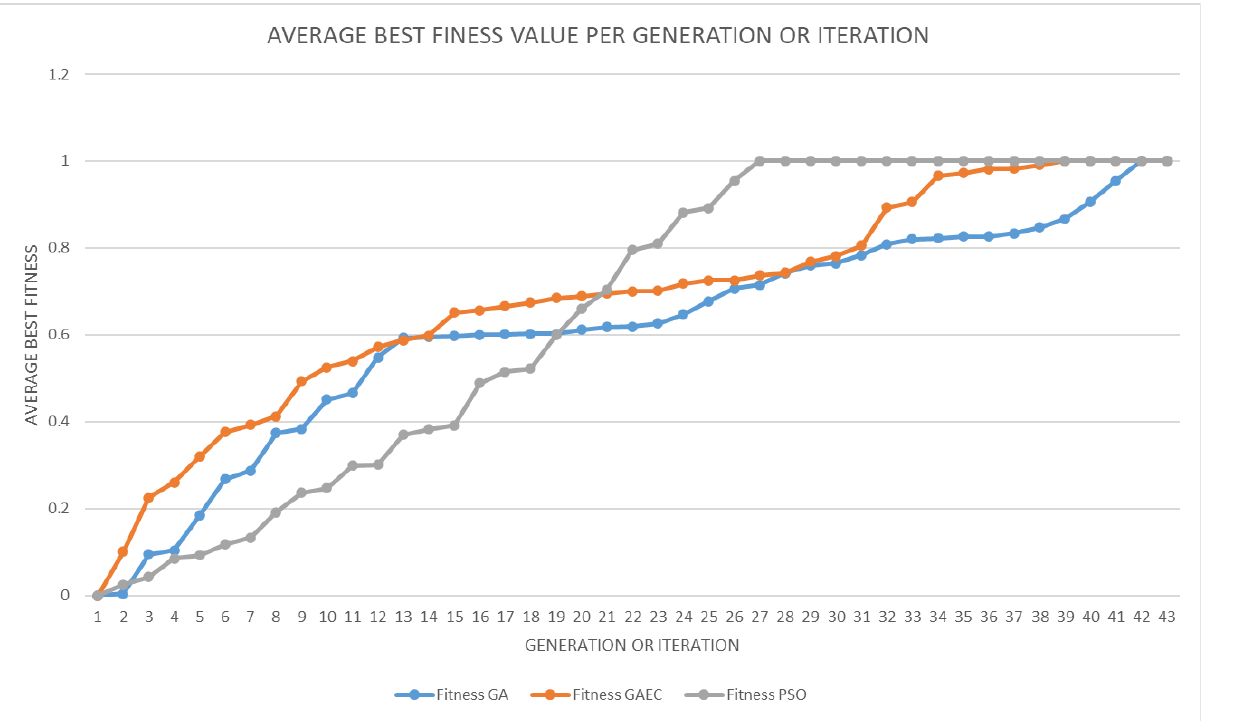
Figure 9. Best fitness values per generation for 10 parameters in GA.